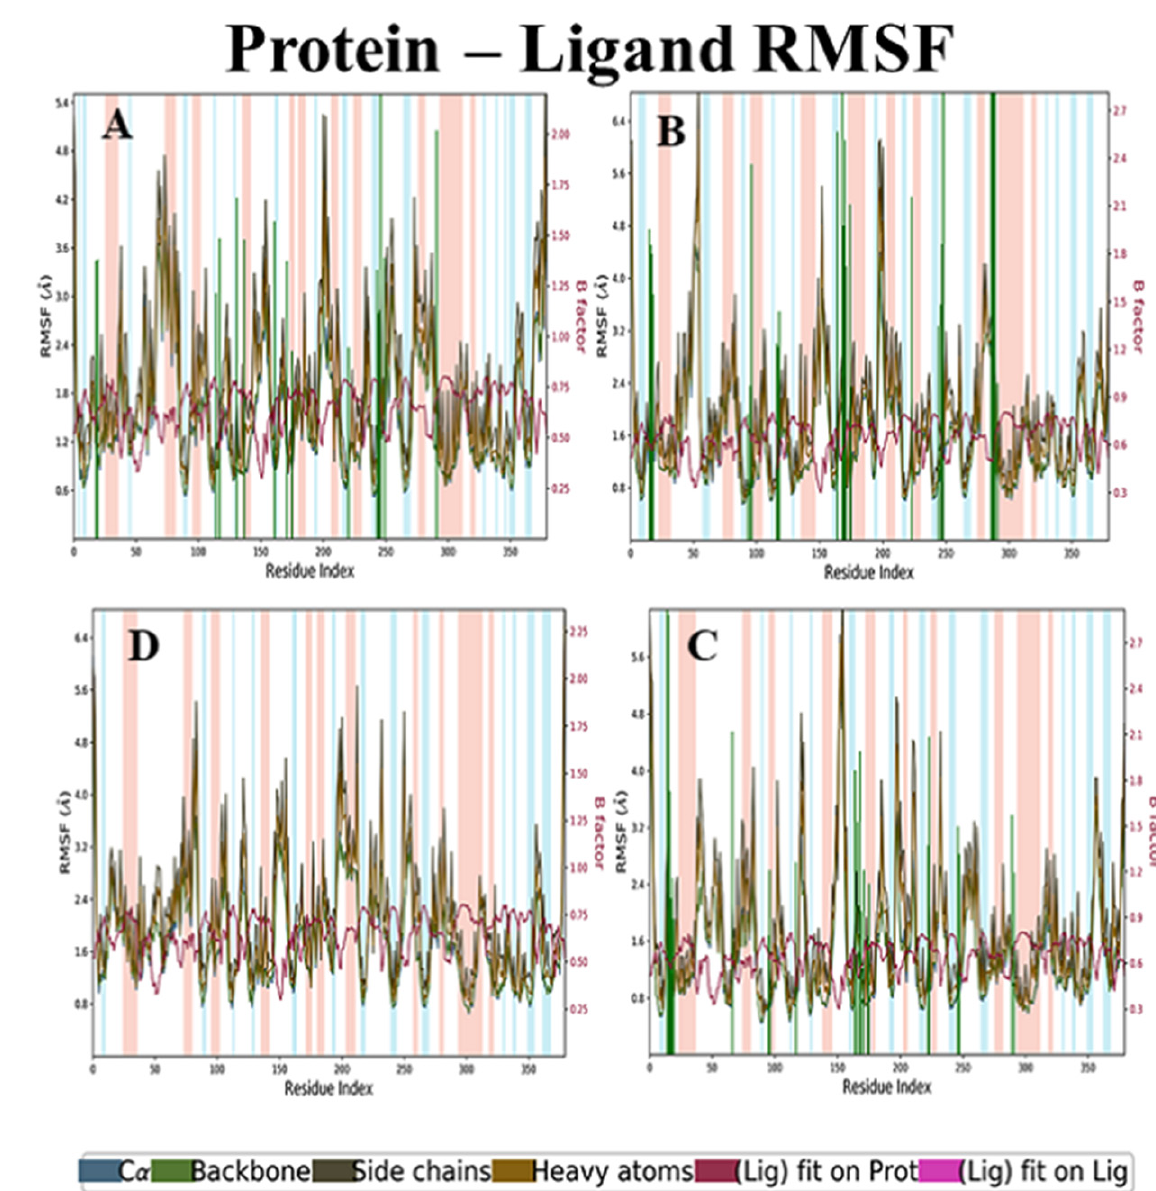
Figure 7. Residue RMSF analysis of lead compounds and ECD GC-C protein complexes. ( A ) Holanamine, ( B ) Holadysenterine, ( C ) Pubescine, ( D ) No ligand. The background color denotes helix (light pink) and loop (sky blue) regions of the protein.